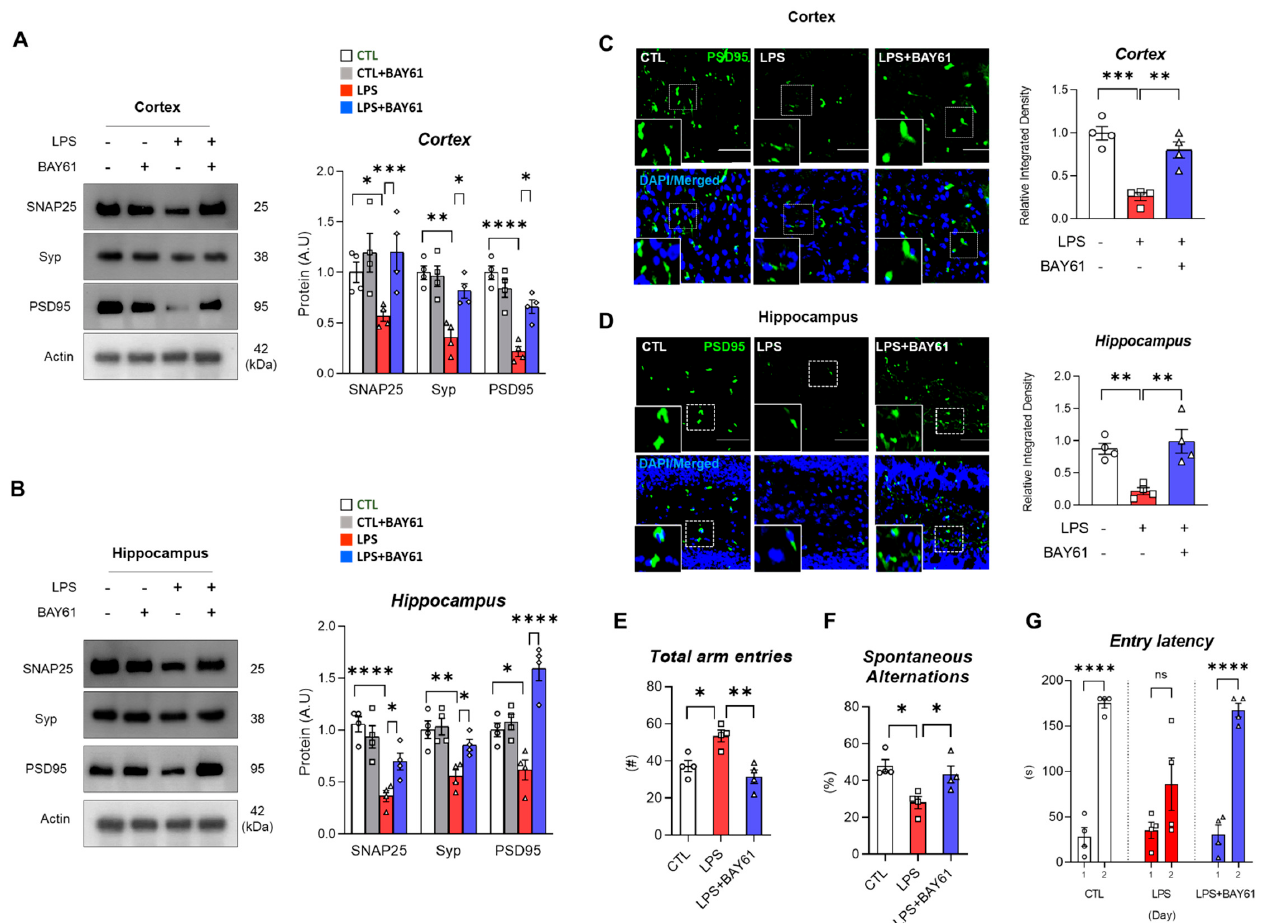
Figure 7. BAY61-3606 improves LPS-induced synaptic dysfunction and memory impairments. Im- munoblot and quantification of SNAP25, Syp and PSD95 in LPS-treated model with or without BAY61-3606 in ( A ) cortex ( n = 4) and ( B ) hippocampus ( n = 4). Representative immunofluorescence images of ( C ) cortex and ( D ) hippocampus treated with PSD95 antibodies. Scale bars, 25 μ m. Spatial working memory was measured by Y-maze test. In the test, ( E ) total arm entries, ( F ) spontaneous alternations were measured by automatic video tracking system. ( G ) Learning memory was mea- sured by fear-aggravated test: passive avoidance. Bar graph color, white: control, grey: control with BAY61-3606, red: LPS, blue: LPS with BAY61-3606. Values indicate the mean ± SEM. The significant differences have been given in the graphs as follows: ns: not significant, * p < 0.05, ** p < 0.005, *** p < 0.0001, **** p < 0.00001 compared with a group of interests and determined by one-way ANOVA followed by Tukey’s multiple comparison test. Abbreviations: LPS, lipopolysaccha- ride; SNAP25, Synaptosomal-associated protein, 25 kDa; Syp, synaptophysin; PSD-95, postsynaptic density